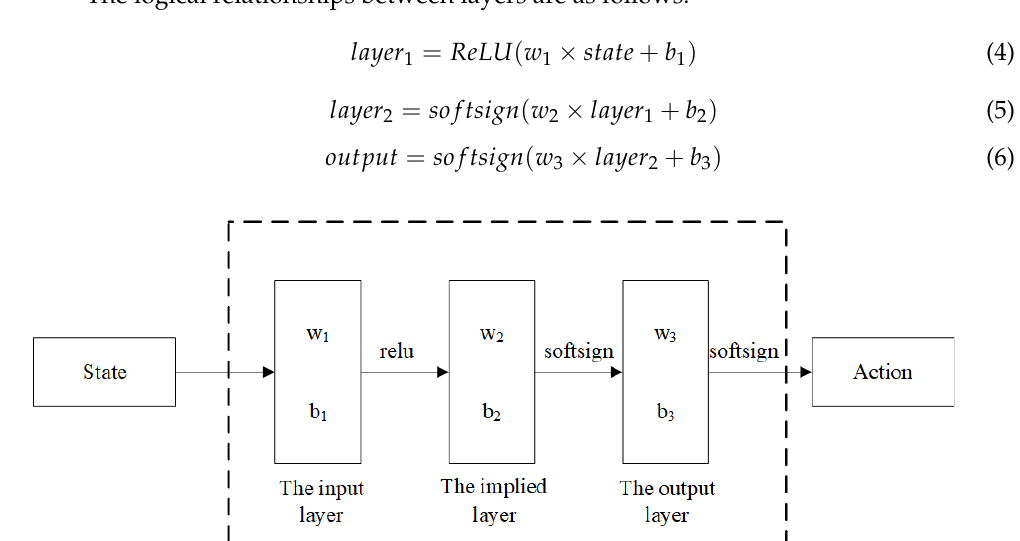
Figure 2. Actor network structure.